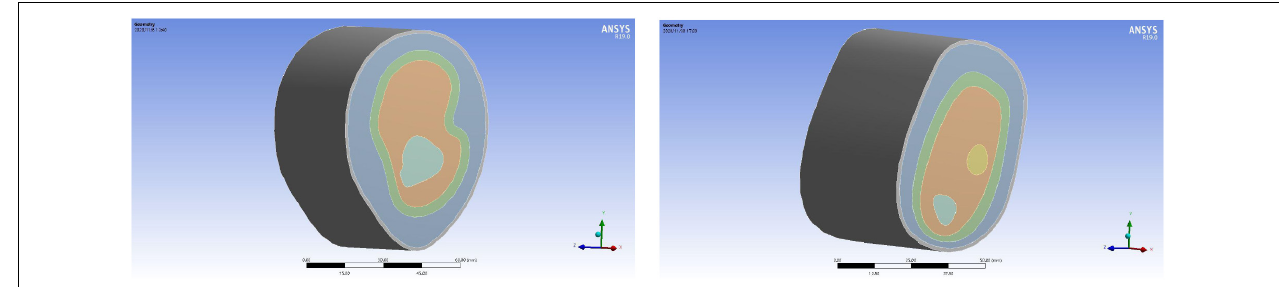
FIGURE 7 | Reconstructed model of upper limb